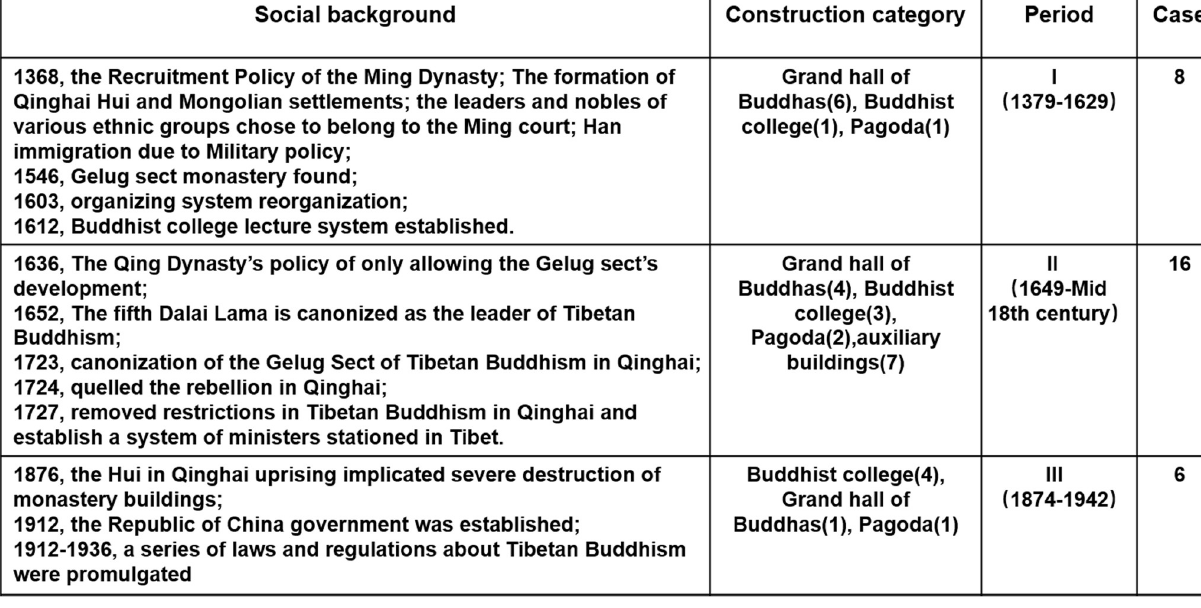
Fig 4. Historical and cultural background of the construction history of Kumbum